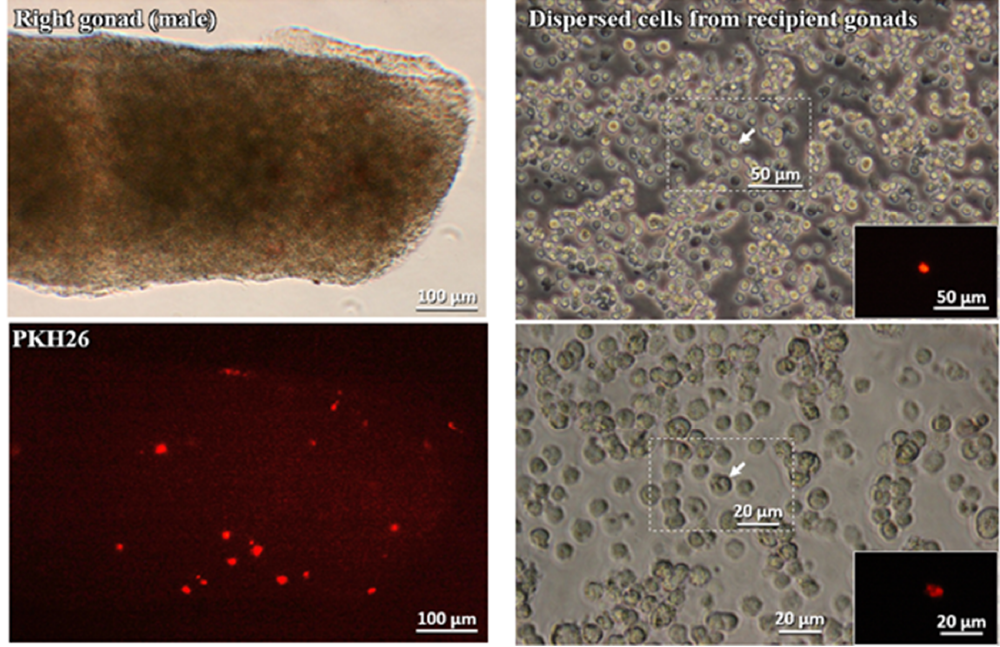
Figure 6. Left panel: The male gonad observed under the microscope (Leica DMI8) and stained with PKH26. Right panel: Dispersed cells from the recipient gonads and stained with PKH26. The cPGCs were seeded and cultured for at least 7 days. One day after seeding the cells, they were counted manually from many fields of view every day for 7 days using the Leica DMI8 microscope and darkfield illumination. cPGCs were visible as bright cells distinctive from cells of the other types. Figure 7 shows that the cells proliferated and their fold change increased every day. Compared to PGCs obtained from chick embryo gonads, the fold change of cPGCs was higher. Within 7 days, the cells proliferated from one cell to 28 cells.